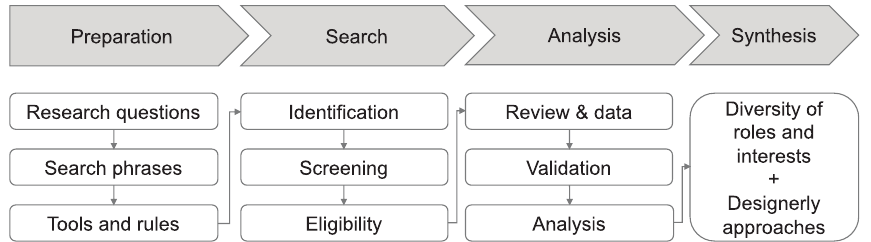
Fig. 1: Phases of the